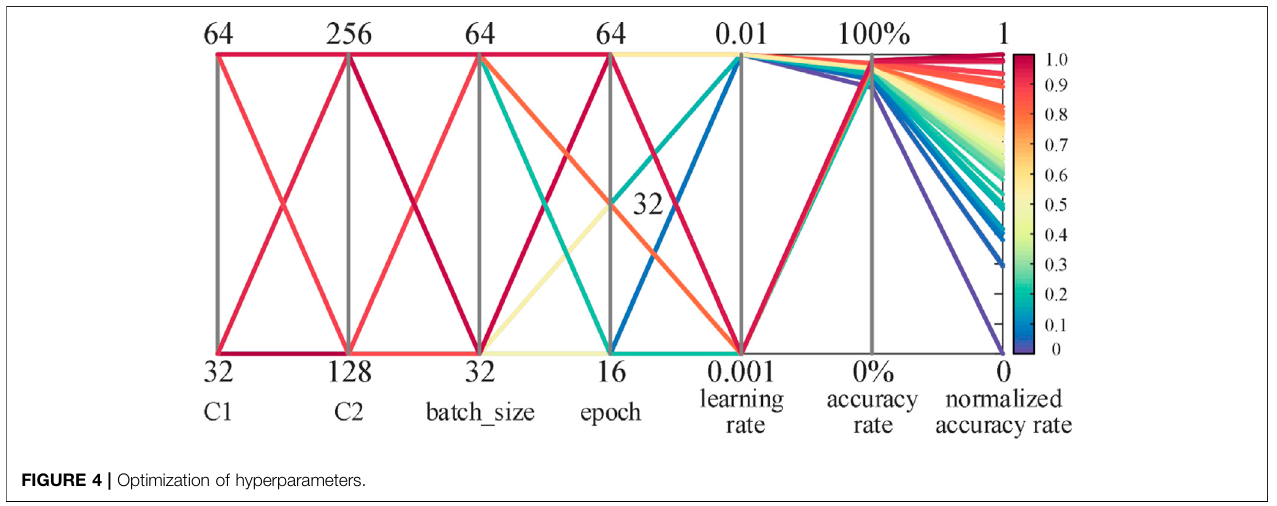
FIGURE 4 | Optimization of hyperparameters.